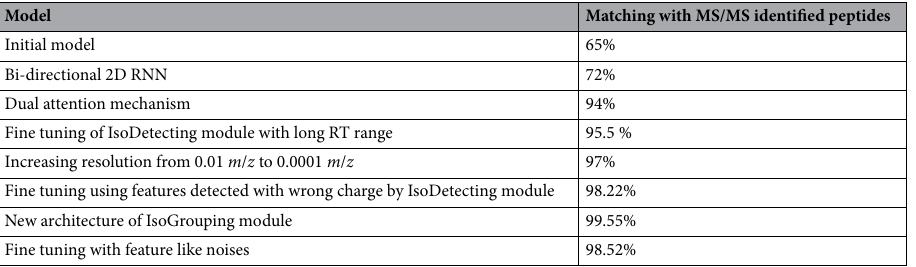
Table 3. Performance of PointIso in different developmental stages (based on validation dataset).